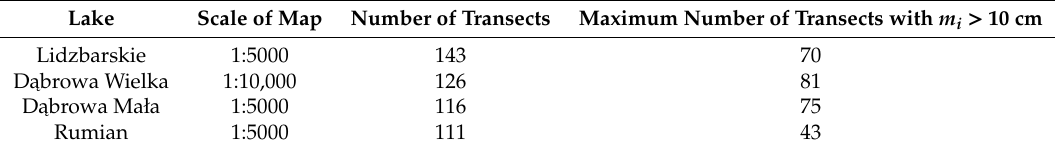
Table 6. Characteristics of lakes—the basis for determining the minimum number of transects on bathymetry plans to calculate the vegetation depth C max .